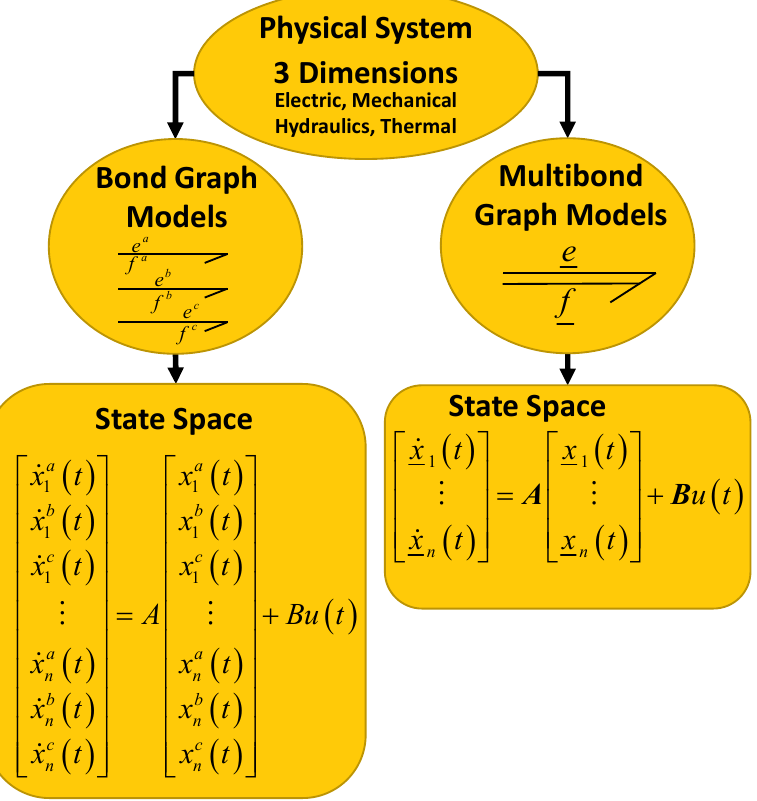
Figure 1. Comparison between bond graphs and multibond